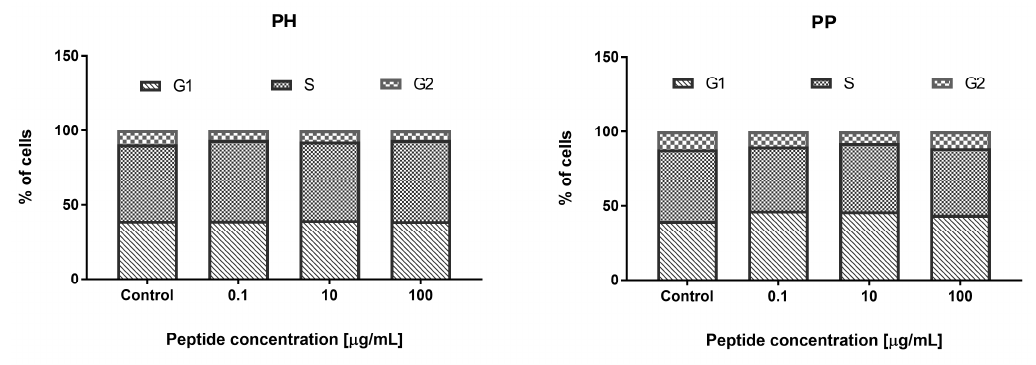
Figure 8. Evaluation of cell apoptosis, necrosis, and viability with PH and PP.